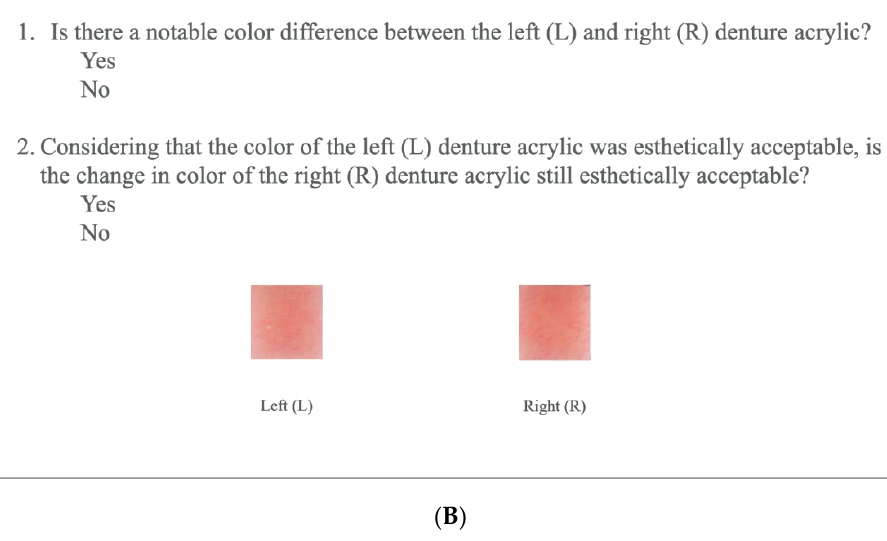
Figure 3. ( A ) . PMMA specimen fabrication. ( B ) Survey questions for patients and clinicians.